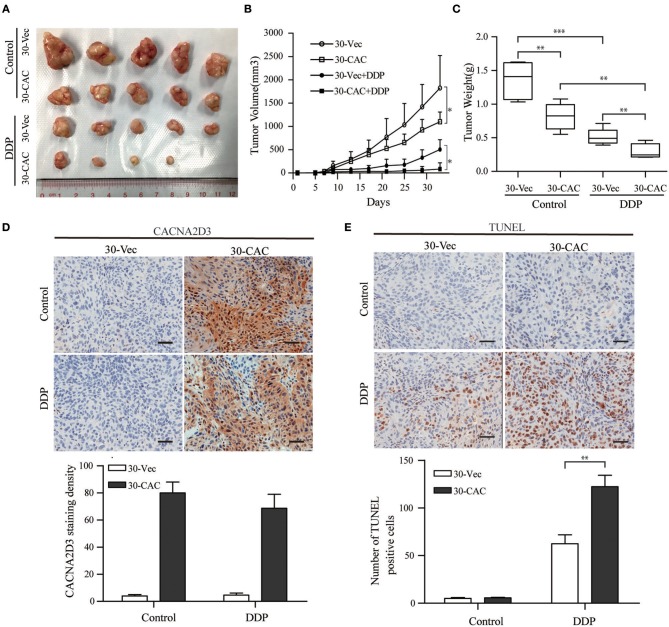
CACNA2D3 increases chemosensitivity of ESCC cells to cisplatin in vivo. (A) Representative images of xenografted tumors derived from Balb/c-nu mice at day 33. (B) The mice in the treatment groups were intraperitoneally injected with 2 mg/kg every 3 days. Tumor volumes were measured at 4 days intervals. Data are presented as mean ± SD. (C) Tumor weights were measured after mice were sacrificed. (D) Detection of CACNA2D3 from tumor sections by immunohistochemical staining. Quantification was performed by calculating the percentage of the staining intensities using ImageJ. (E) TUNEL staining of tumor sections from each group; the number of TUNEL-positive cells was quantified by counting. *p < 0.05; **p < 0.01; ***p < 0.001.